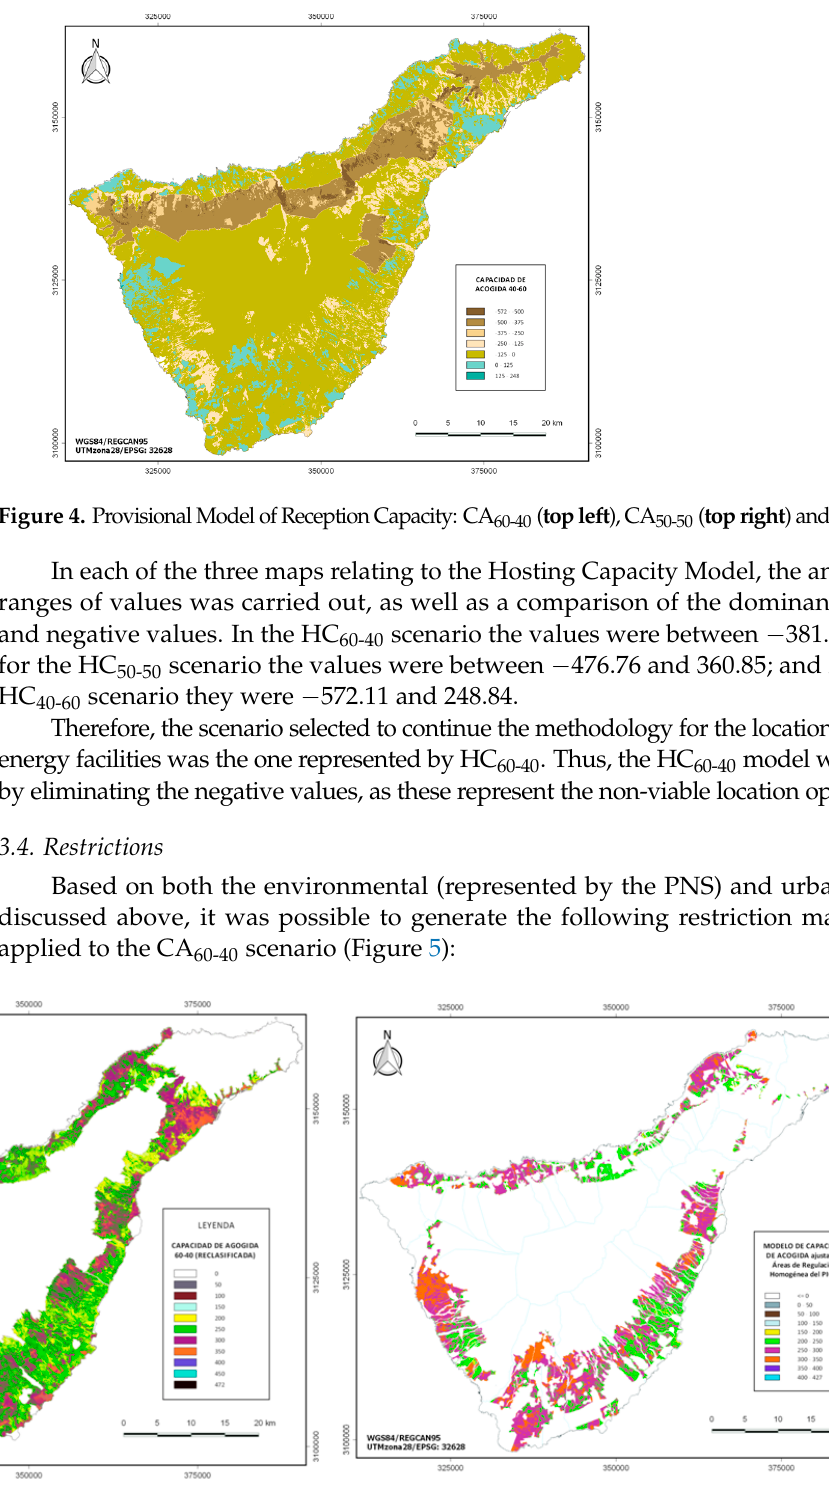
Figure 5. Reception Capacity Model 60-40 reclassified after applying the environmental restriction of Protected Natural Space ( left ) and Reception Capacity Model adjusted to Homogeneous Regulatory Areas (PIOT) ( right ).